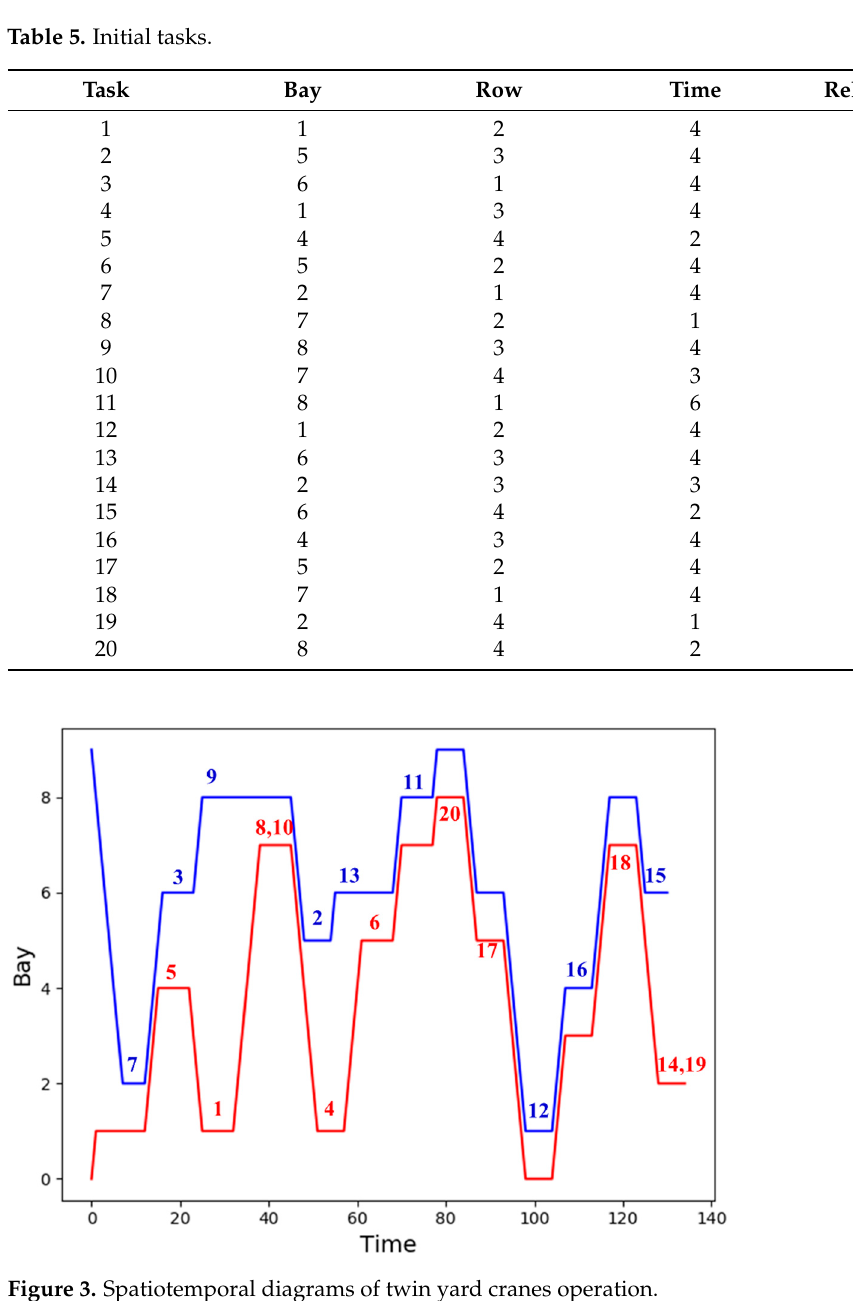
Figure 3. Spatiotemporal diagrams of twin yard cranes operation .